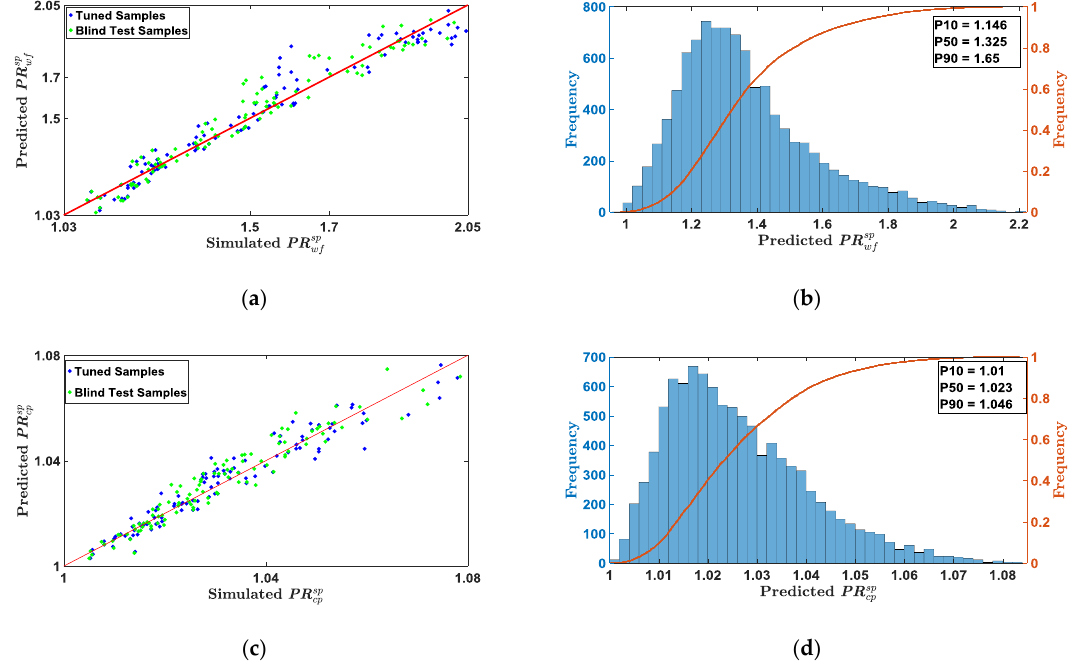
Figure 13. Assessment of proxy quality as part of the surrogate modeling workflow ( a , c ) and resulting probabilities from the Monte Carlo simulation ( b , d ) for the average injection bottom hole pressure ratio of the slug-based process to waterflooding ( a , b ), and to continuous polymer flooding ( c , d ).